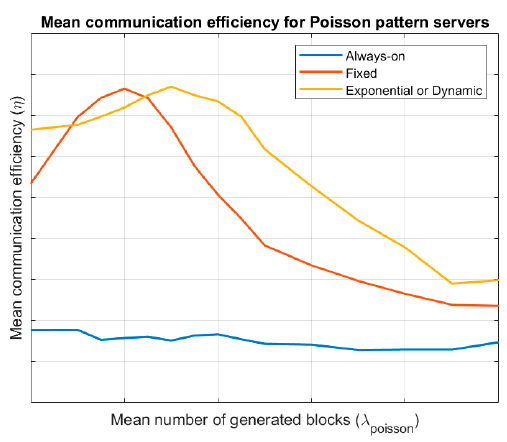
Figure 5. Mean communication efficiency for Poisson pattern servers.